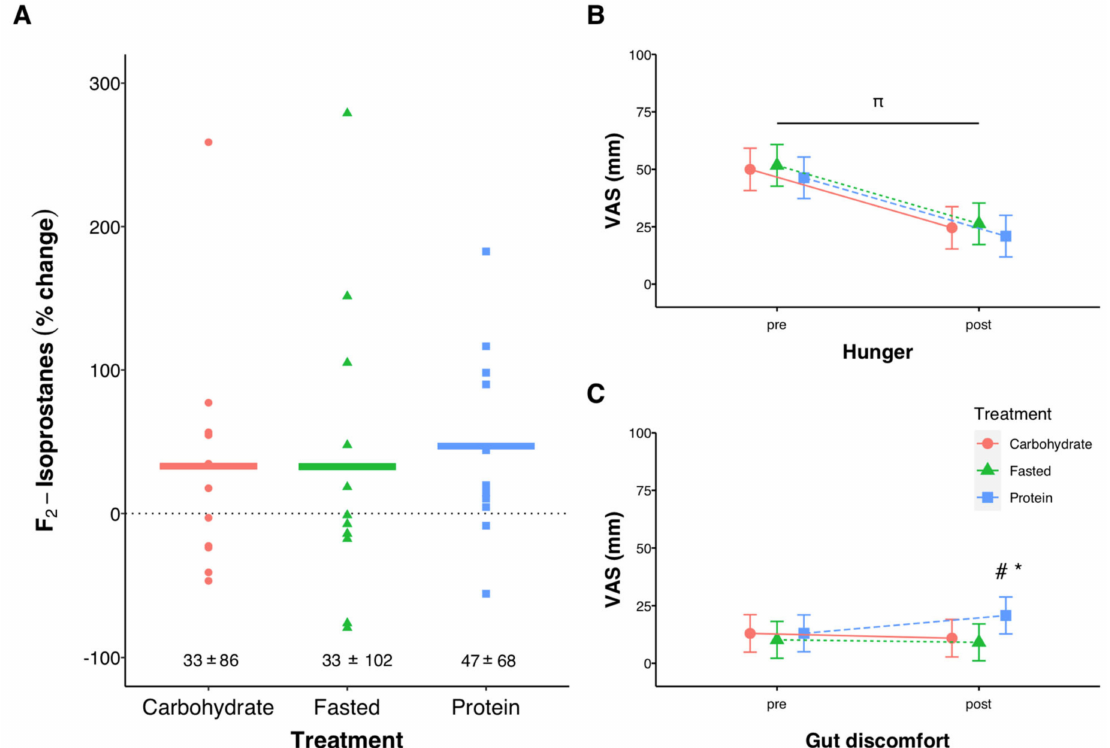
Figure 5. Urinary F 2 -Isprostane percent change (pre to post-exercise, ( A )), and subjective levels of hunger ( B ) and gut discomfort ( C ) before and after exercise using a visual analog scale (VAS). All measurements at ‘pre’ were taken upon arrival to the lab in the overnight-fasted state, before being provided any nutrition treatment. In ( A ) individual data points are shown with solid lines representing means and the numeric values reflecting mean ± SD. In ( B , C ) error bars represent 95% confidence intervals of the model-estimated mean. π significant effect of time ( p < 0.001), significant effects of treatment ( # PROTEIN vs. CARB, p = 0.012, * PROTEIN vs. FASTED, p = 0.032) at the post time point. For ( A ), n = 12 for Carbohydrate, n = 12 for Fasted, and n = 11 for